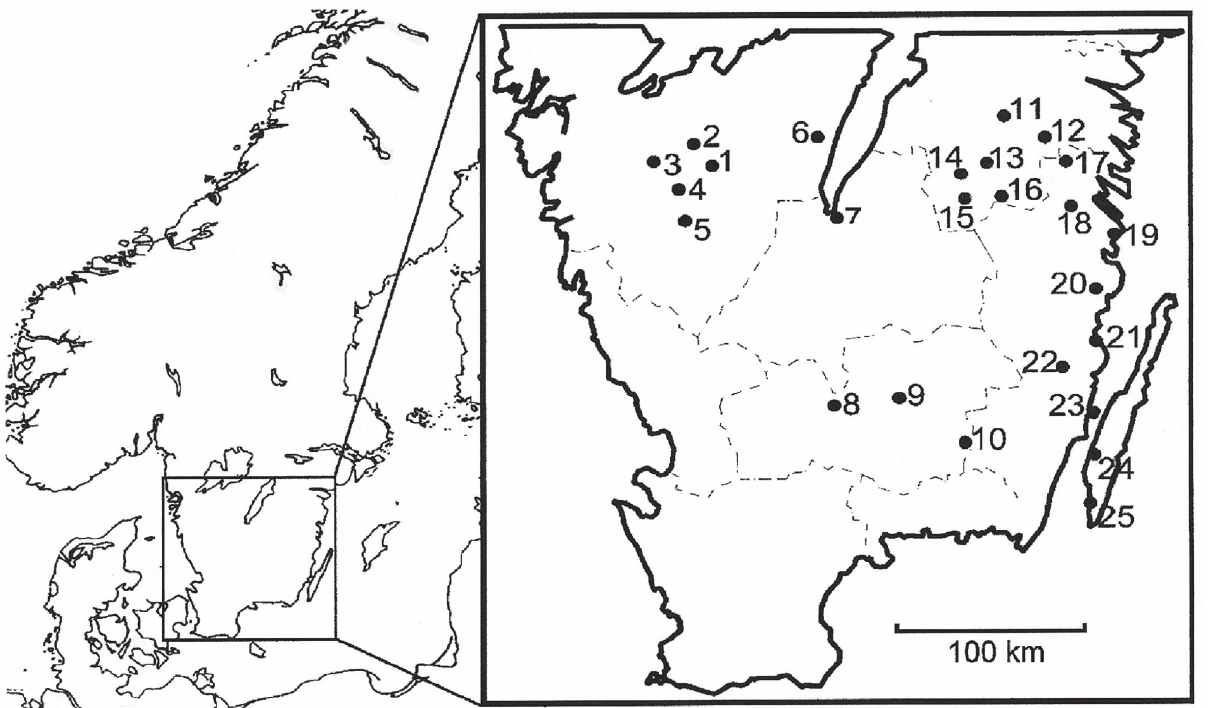
Fig 1. Study area in southern Sweden with the 25 forest sites used in the experiment. Each site contained one experimental thinning plot (1 ha) and one minimal intervention plot (1 ha), before the treatment similar in forest structure. For names and description of sites, see Table